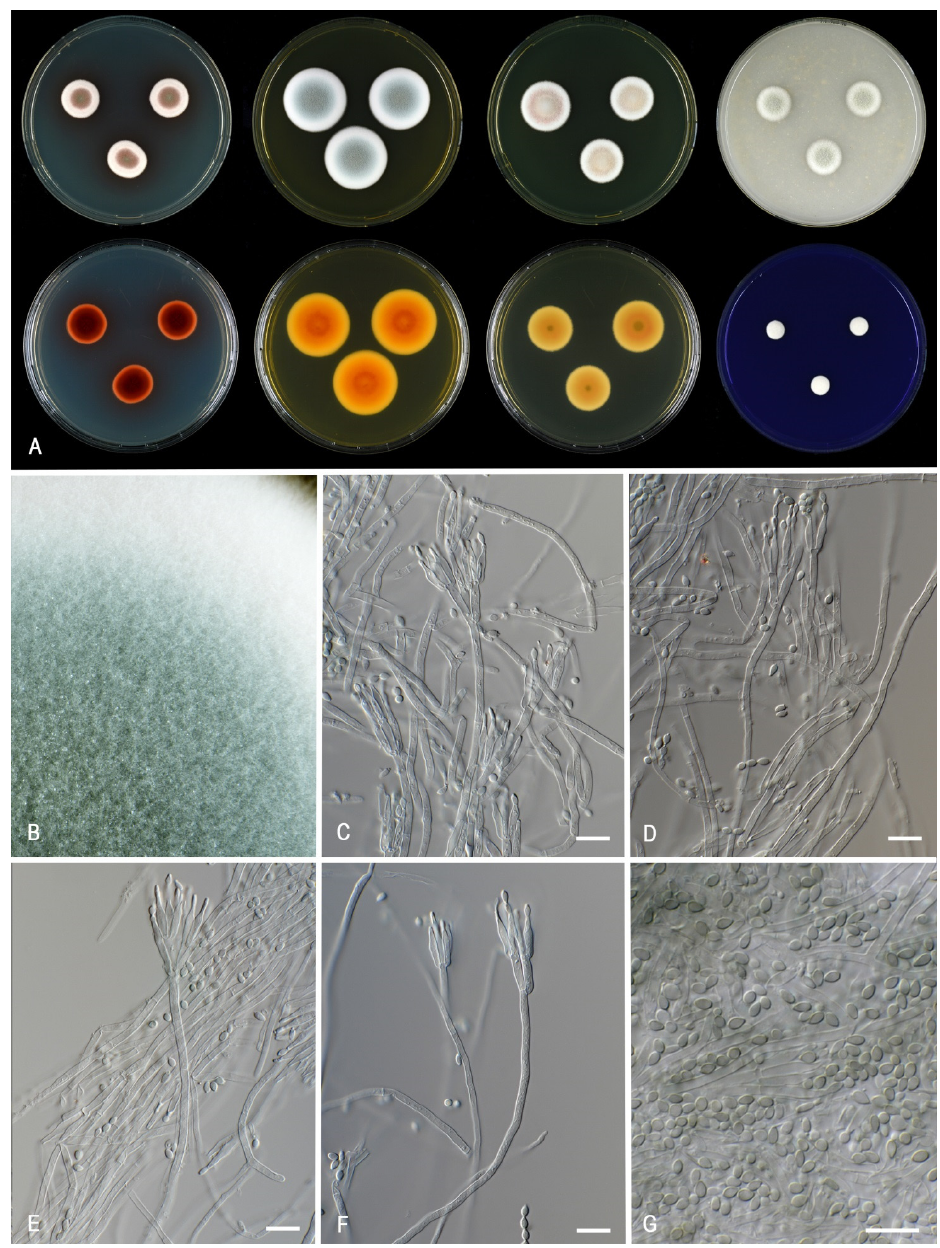
Figure 7. Morphological characters of Talaromyces chongqingensis (CBS 147316). ( A ). Colonies, from left to right, after 7 d at 25 °C (top row) CYA, MEA, YES, OA; (bottom row) CYA reverse, MEA reverse, YES reverse, CREA. ( B ). Detail of colony on MEA. ( C – F ). Conidiophores and conidia. ( G ). Conidia. Scale bars = 10 μ m.